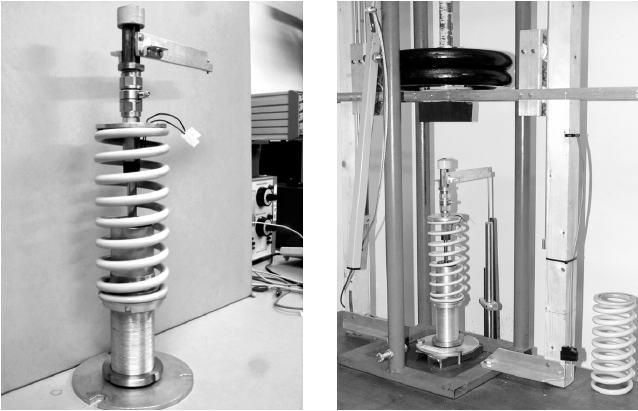
Fig. 17. (left) Laboratory model of Adaptive Impact Absorber (AIA); (right) AIA mounted on the laboratory drop test